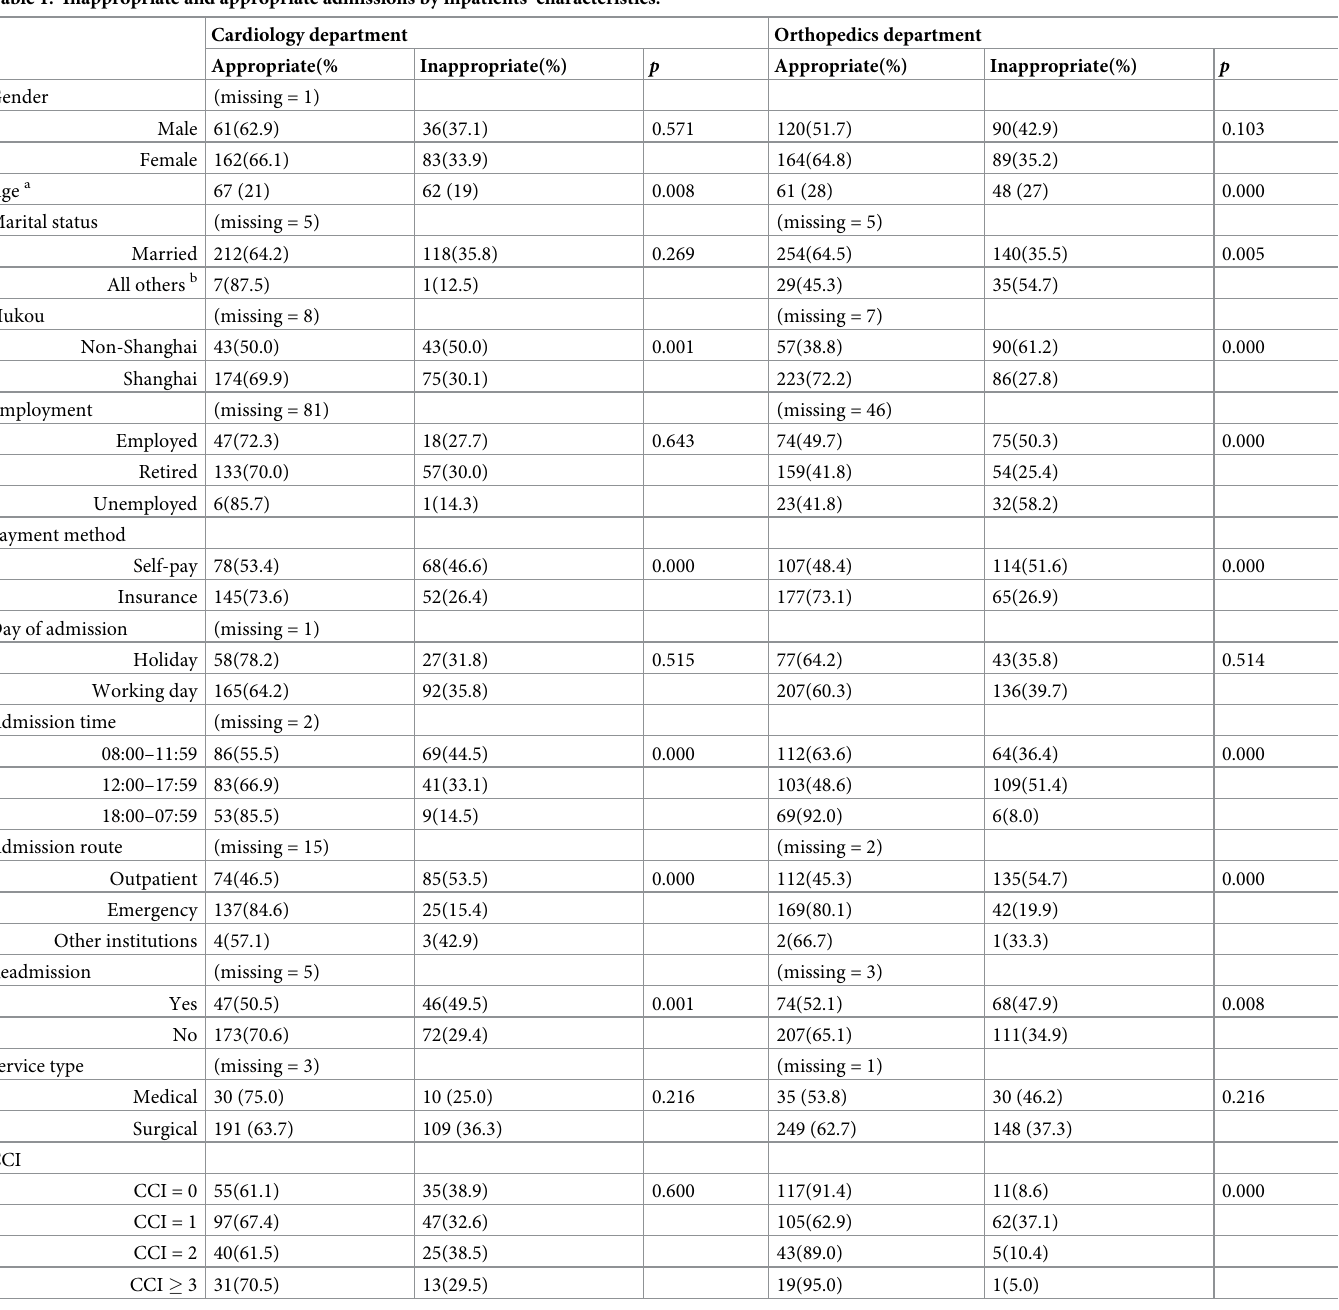
Table 1. Inappropriate and appropriate admissions by inpatients’